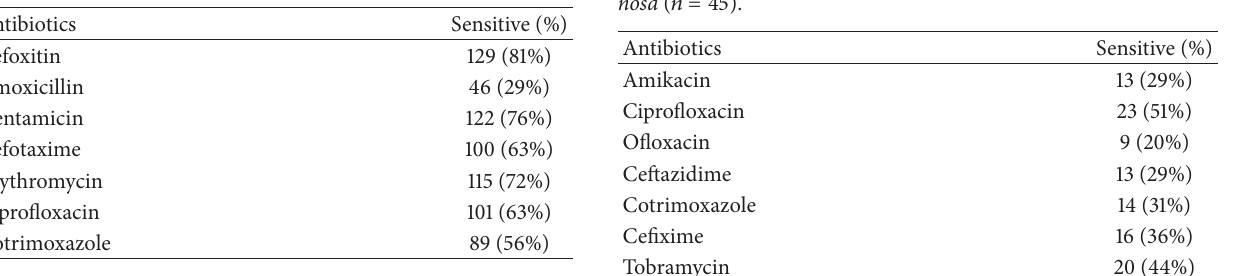
Table 2: Antibiotic susceptibility patterns of S. aureus .